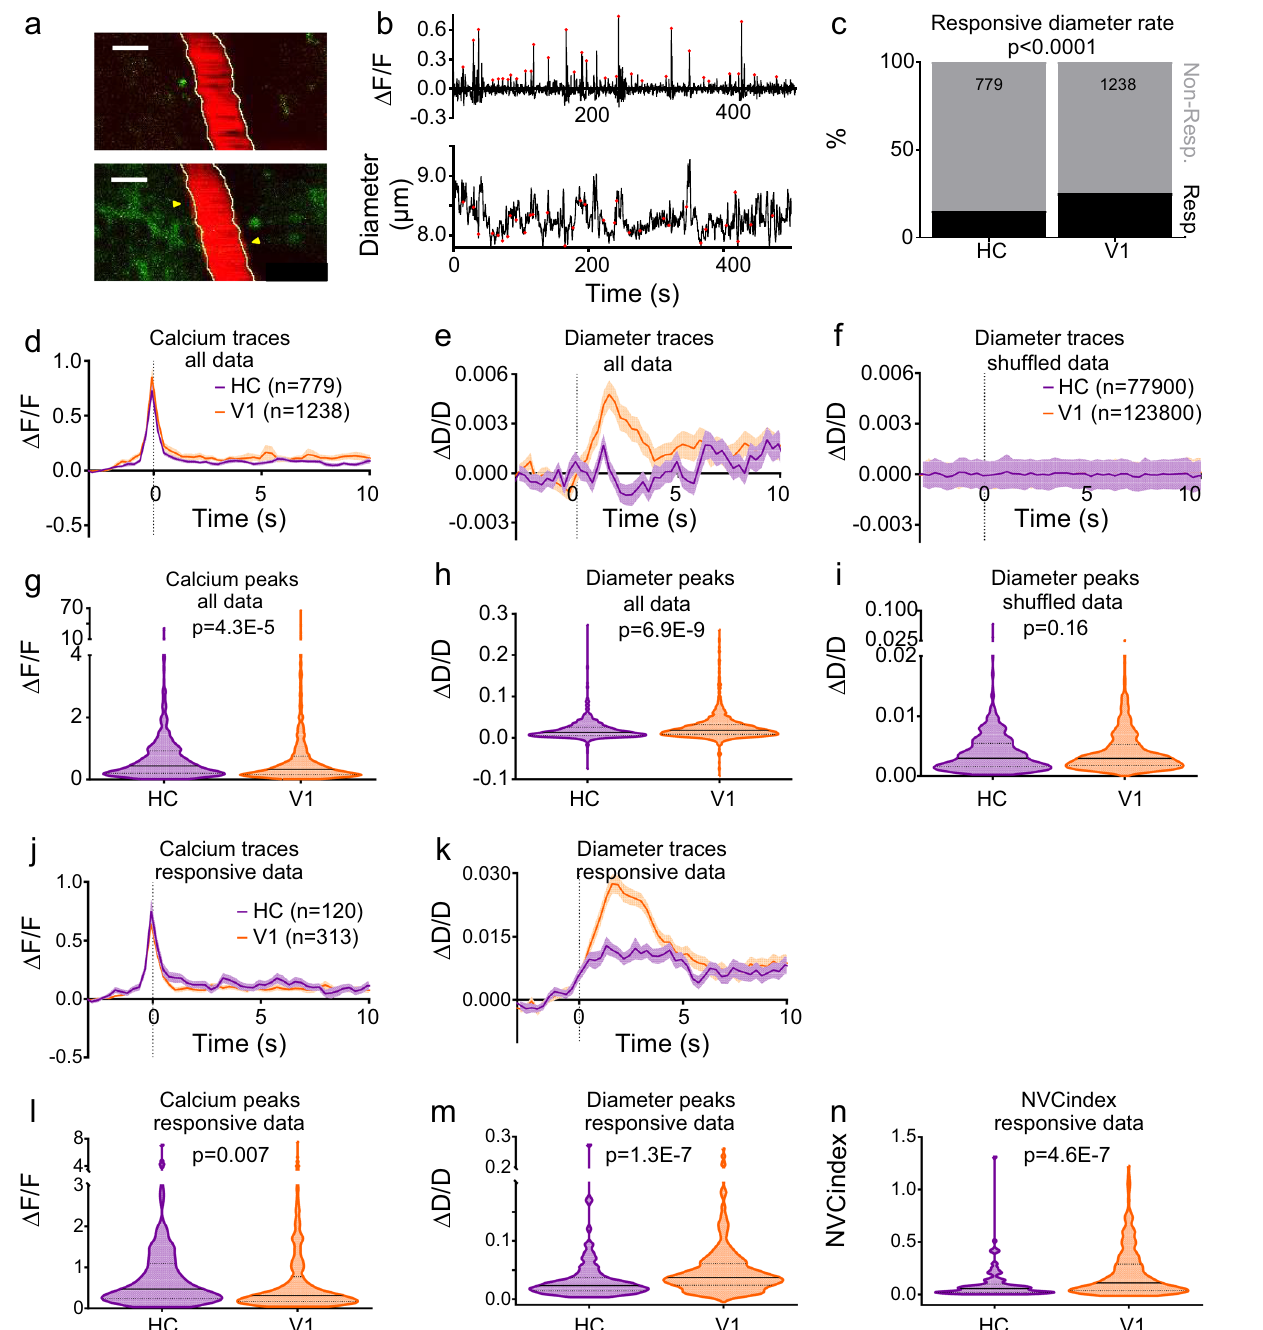
Fig. 3 Vessel responses to local neuronal calcium events. a Texas Red dextran- fi lled vessel (red) and GCaMP6f-positive pyramidal neurons (green) from one recording in V1 before (top) and during (bottom) increases in neuronal calcium (to represent the 87 vessels with local neuronal calcium imaged). Yellow outlines show vessel before calcium event. Arrows indicate the largest dilation. Scale bars represent 5 μ m. b Neuronal calcium averaged over all cells in the fi eld-of-view of one imaging session and the corresponding vessel diameter. Red dots mark calcium events. c Vessel responses to preceding calcium events were more frequent in V1 than HC (Chi-square test). d Average calcium response and e diameter change in HC (purple, N = 779 trials, 46 vessels, 6 animals) and V1 (orange, N = 1238 trials, 41 vessels, 7 animals). f Diameters when vessel traces were shuf fl ed 100 times so no longer aligned to calcium events (HC N = 77900 events, V1 N = 123800). g The calcium events were larger in HC compared with V1. h Vessel dilations were larger in V1 than HC when aligned to calcium events, i but not when shuf fl ed (statistical comparisons were made on individual calcium/dilation/shuf fl ed dilation events, N speci fi ed in d/e & f). j Calcium events that led to dilations in HC ( N = 120 events, six mice) and V1 ( N = 313 events, seven mice). k Corresponding diameter changes. l Calcium peaks leading to dilations were higher in HC ( N = 120, V1 N = 313). m Diameter peaks were signi fi cantly larger in V1 than HC. n A neurovascular coupling index (NVC index ) was calculated by dividing each dilation peak by its corresponding calcium peak. NVC index was lower in HC than V1. P values are from Mann – Whitney U tests, unless stated (see Statistics Report Tables SR2a – b). Averages and shaded error bands show mean ± SEM. Horizontal lines on violin plots show median and interquartile range. Source data are provided as a Source Data fi le.